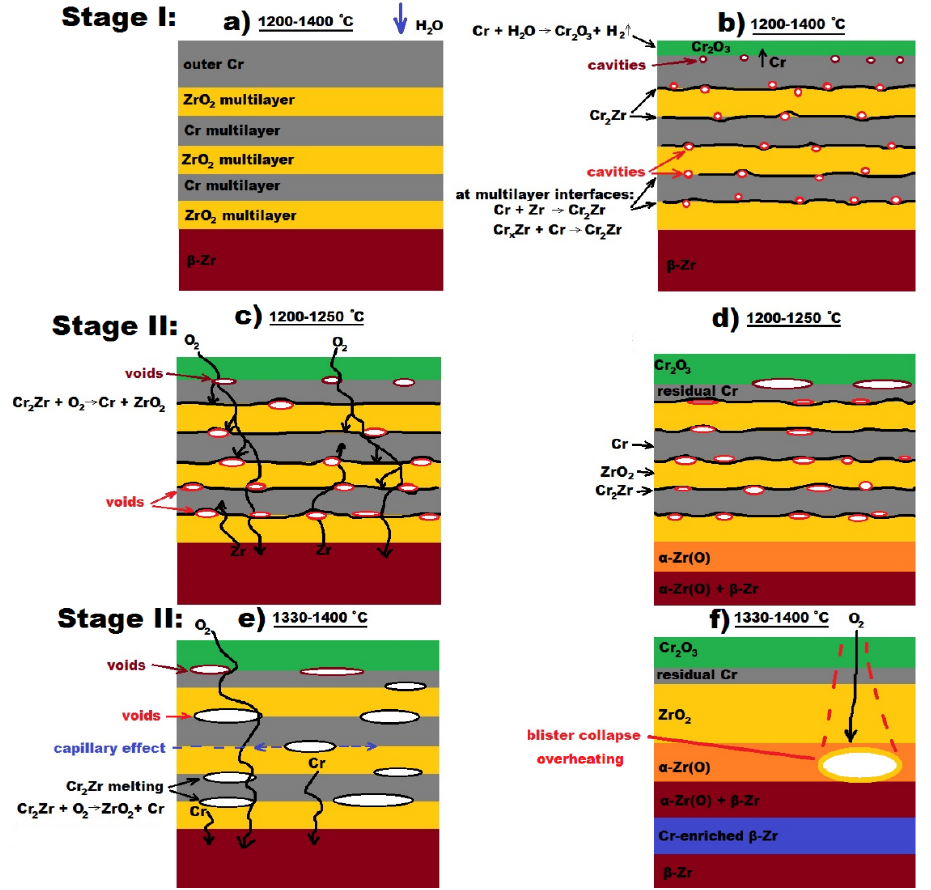
Figure 15. Schematic diagram of the oxidation process for the Cr-coated Zr alloy with the ZrO 2 /Cr multilayers: ( a )—initial state; ( b )—stage I; ( c , d )—stage II for 1200–1250 ◦ C; ( e , f )—stage II for 1330–1400 ◦